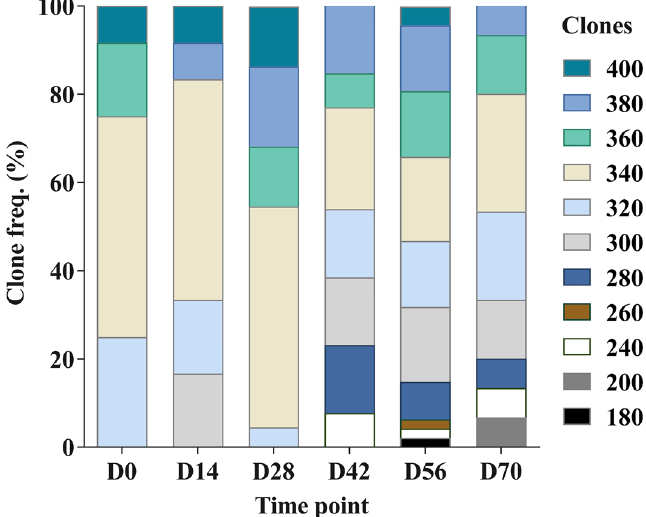
Figure 2. Distribution and duration of circulating gametocyte clones. At each time point analyzed [Day (D)] the different gametocyte clones (n = 11) detected in the subpopulation (n = 149) of infected samples tested are shown. Clonal frequency and distribution differed between time points. The highest number of diverse clones were observed on days 56 and 70. Clones below 300 bp (180–280) were least represented and observed only after day